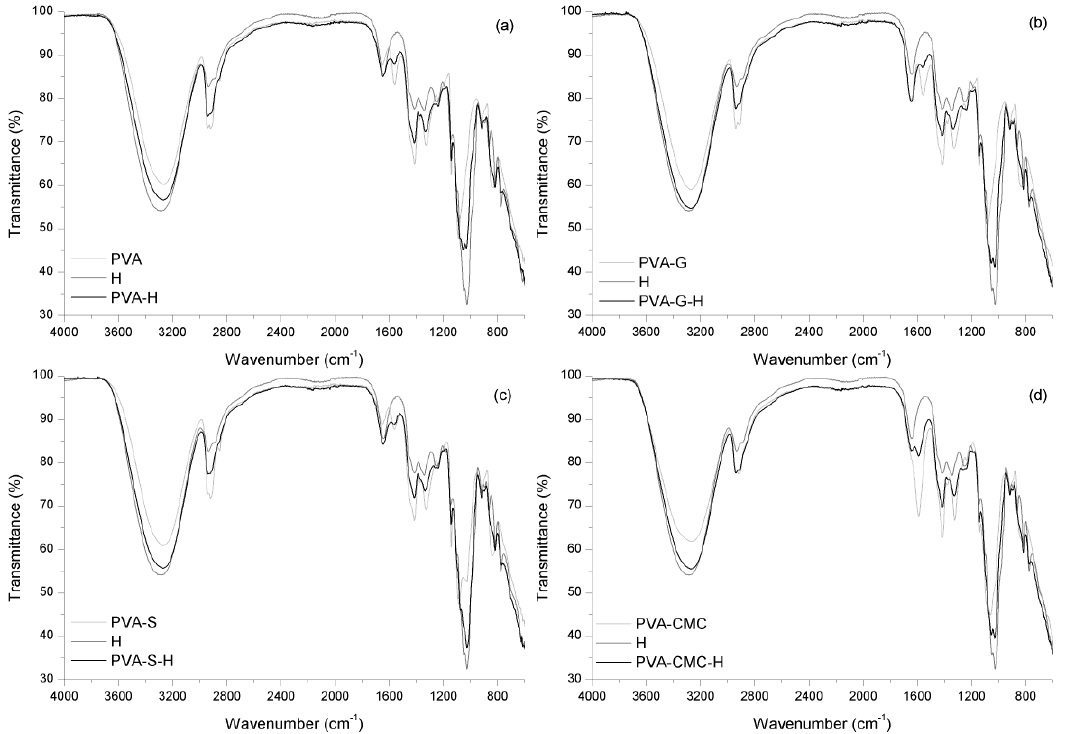
Figure 2. Spectra of PVA blends loaded with honey: ( a ) PVA, honey, and PVA incorporating honey; ( b ) PVA – gelatin, honey, and PVA – gelatin incorporating honey; ( c ) PVA – starch, honey, and PVA – starch incorporating honey; ( d ) PVA – CMC, honey. and PVA – CMC incorporating honey.